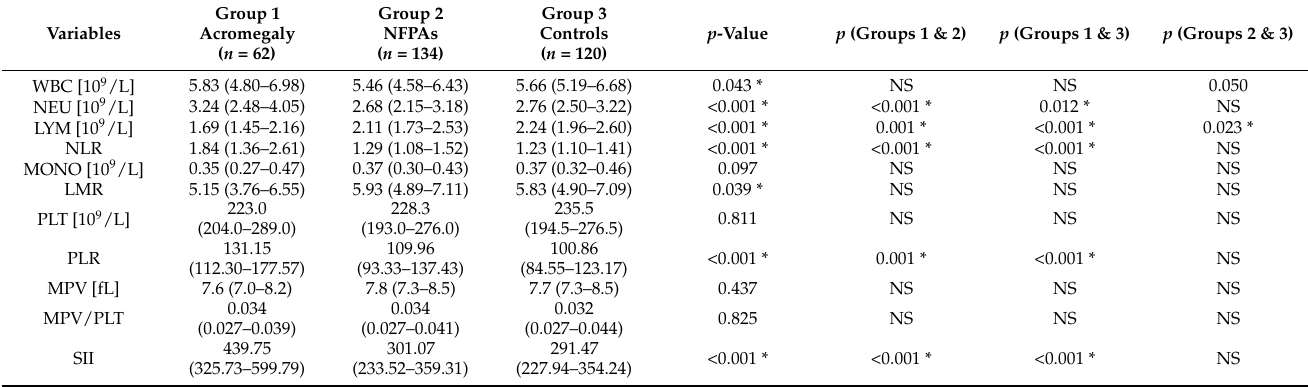
Table 2. Baseline characteristics of laboratory data among three